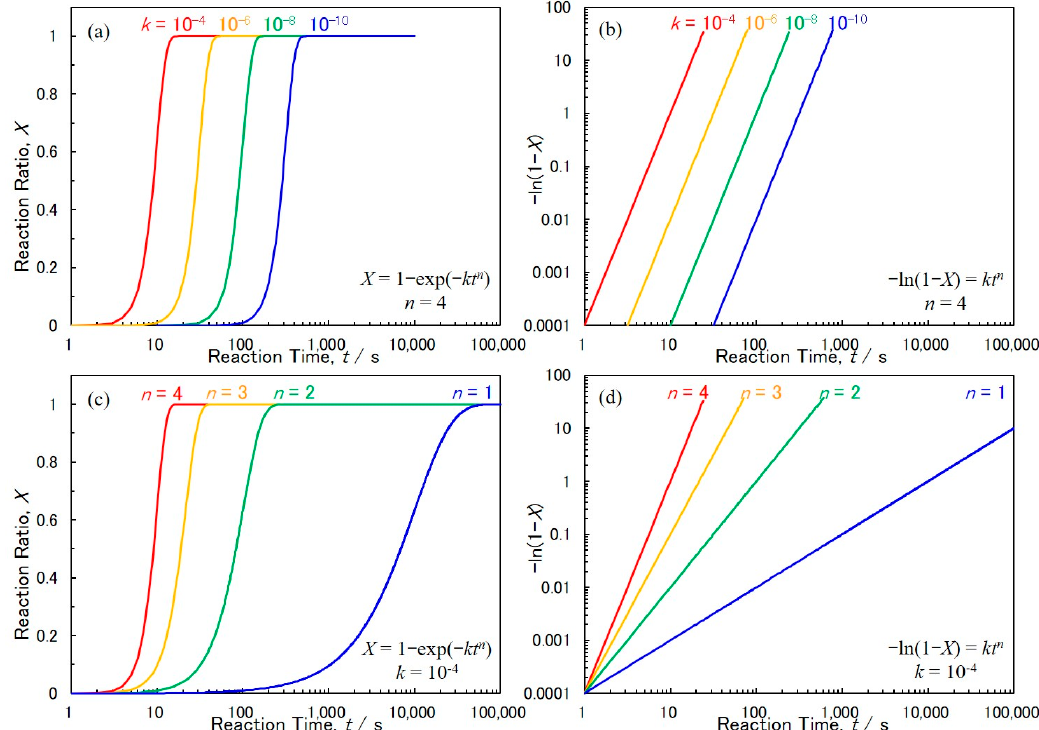
Figure 2. Theoretical simulation concerning the effect of reaction time on the reaction ratio based on